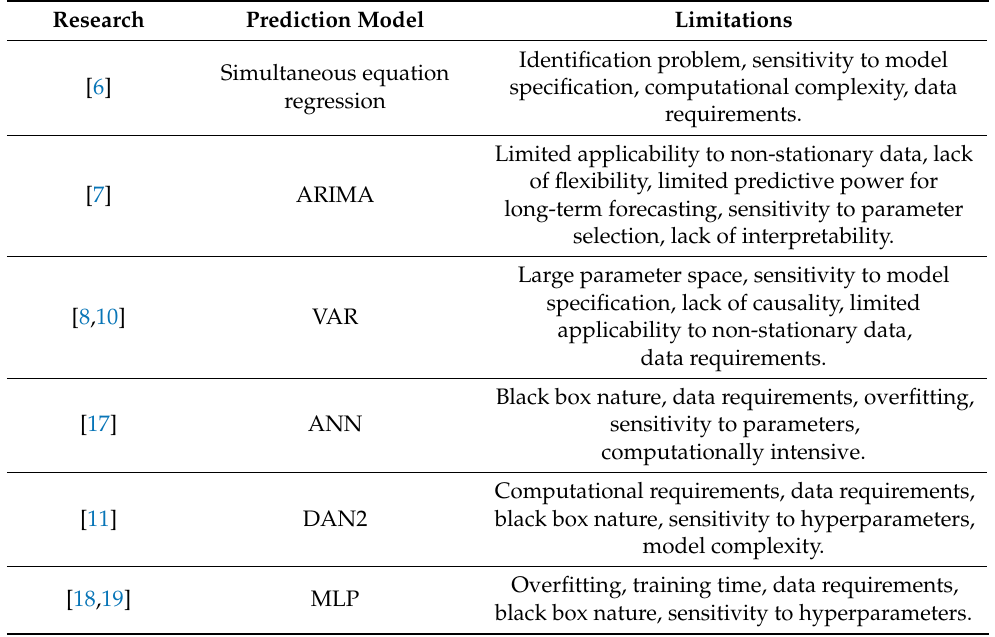
Table 1. Time Series Prediction Models and Limitations of Previous